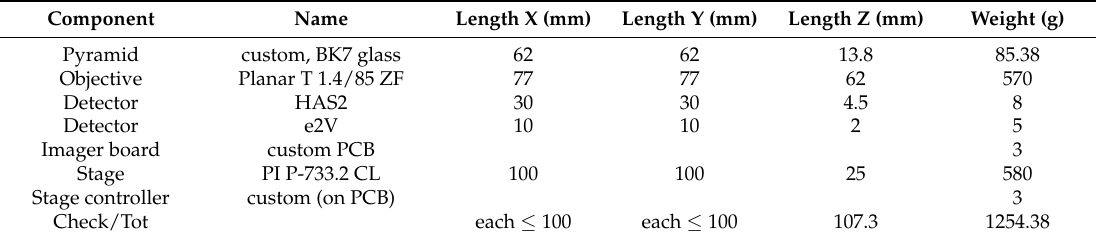
Table 4. List of payload components and budget of dimensions and weight for the payload unit.